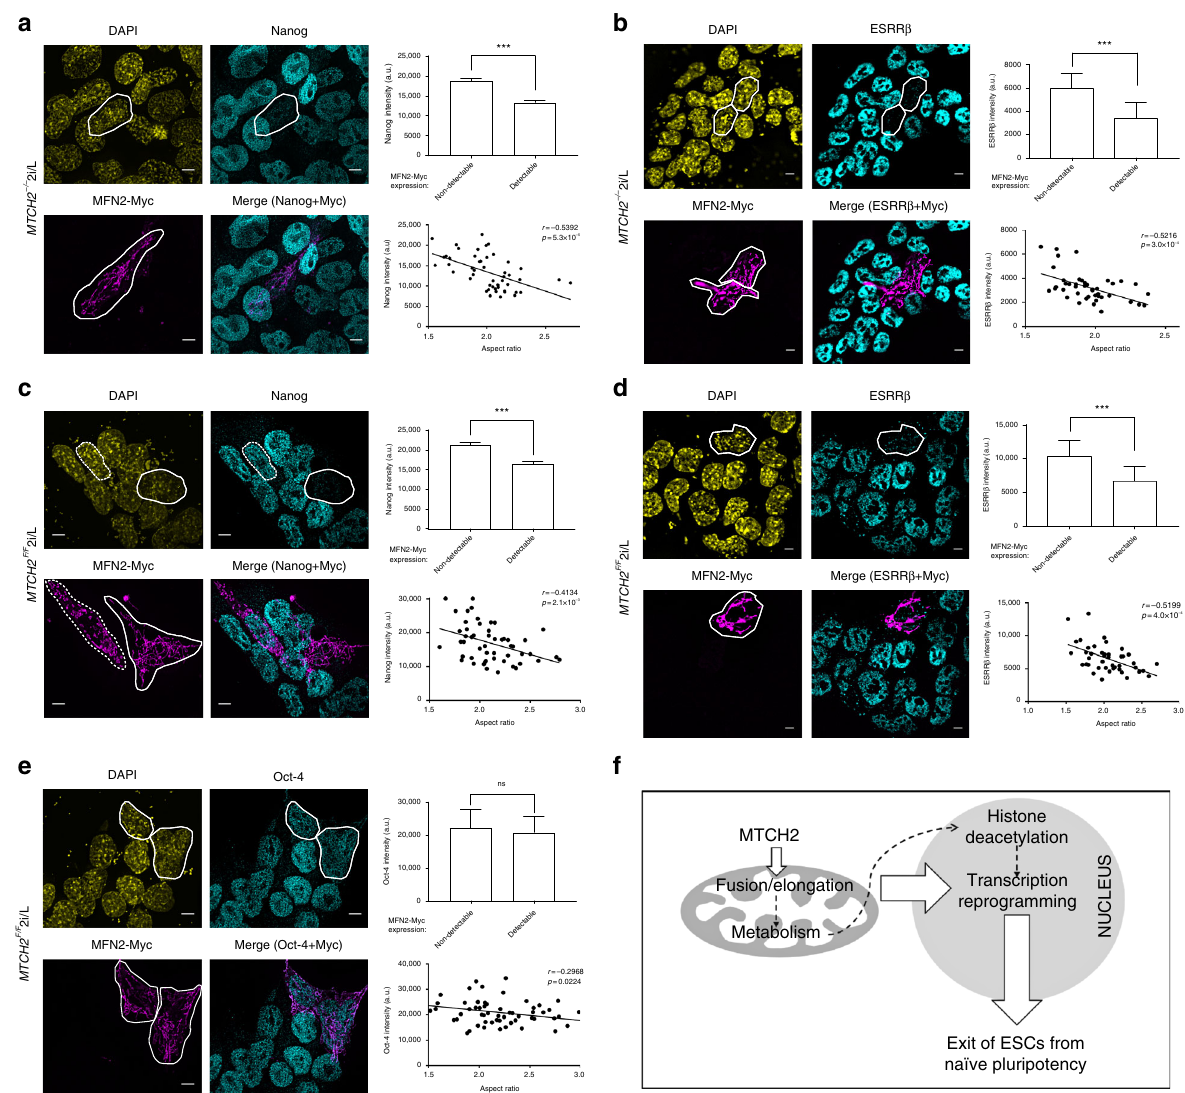
Fig. 4 Mitochondria elongation drives exit from naïve pluripotency. a MFN2-Myc induces mitochondria fusion and represses Nanog expression in MTCH2 − / − ESCs. Left panels: Representative IF images showing Nanog expression in MTCH2 − / − ESCs expressing MFN2-Myc (scale bar, 5 μ M). The cells expressing MFN2-Myc and repressing Nanog are marked with white lines. Top right panel: Average fl uorescent intensity of Nanog in MTCH2 − / − ESCs with either detectable or non-detectable expression of MFN2-Myc. Results are presented as mean ± SEM ( ***p < 0.001; n > 50 cells were scored for each group). Bottom right panel: XY chart of average mitochondrial aspect ratio to mean intensity of Nanog levels in MTCH2 − / − ESCs expressing MFN2- Myc ( n > 50 cells were scored). b Inducing mitochondrial fusion by expressing MFN2-Myc in MTCH2 − / − ESCs represses ESRR β expression levels. Left panels: Representative IF images showing ESRR β expression in MTCH2 − / − ESCs expressing MFN2-Myc (scale bar, 5 μ M). The cells expressing MFN2-Myc and repressing ESRR β are marked with white lines. Top right panel: Average fl uorescent intensity of ESRR β in MTCH2 − / − ESCs with either detectable or non-detectable expression of MFN2-Myc. Results are presented as mean ± SEM ( ***p < 0.001; n > 50 cells were scored for each group). Bottom right panel: XY chart of average mitochondrial aspect ratio to mean intensity of ESRR β levels in MTCH2 − / − ESCs expressing MFN2-Myc ( n > 50 cells were scored). c Expression of MFN2-Myc in MTCH2 F/F ESCs induces mitochondria fusion and represses Nanog expression levels. Left panels: As in a . The cell marked with a dashed line, expresses MFN2-Myc yet possess fragmented mitochondria and maintains Nanog levels. Top and bottom right panels: As in ( a ). d Inducing mitochondrial fusion by expressing MFN2-Myc in MTCH2 F/F ESCs represses ESRR β expression levels. Left panels: As in ( b ). Top and bottom right panels: As in ( b ). e Inducing mitochondrial fusion in MTCH2 F/F ESCs only slightly decreases Oct-4 expression levels. Left panels: Representative IF images showing Oct-4 expression in MTCH2 F/F ESCs expressing MFN2-Myc (scale bar, 5 μ M). The cells expressing MFN2-Myc are marked with white lines. Top and bottom right panels: As in ( a ). f Schematic representation of the role of mitochondrial fusion/elongation, governed by MTCH2, in regulating the exit from naïve pluripotency in